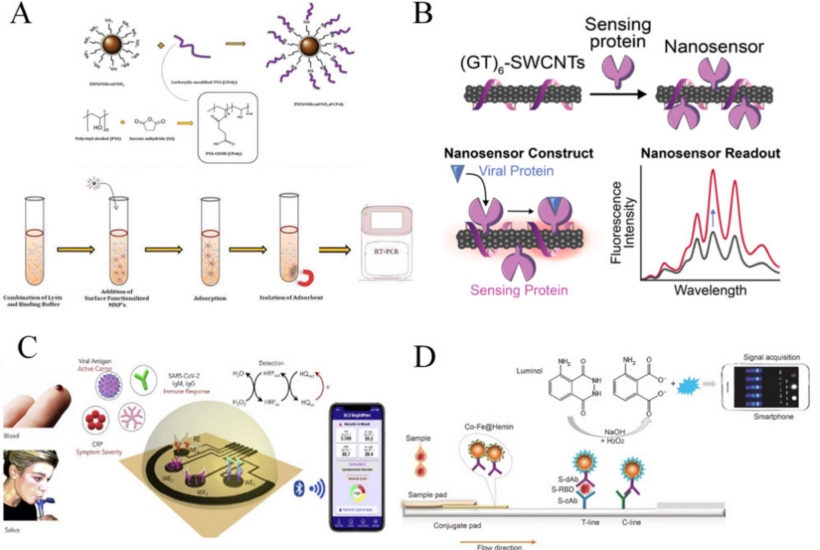
Figure 3. The application of nanoparticles for COVID-19 diagnostics. ( A ) Magnetic particles were used for viral RNA extraction for COVID-19 diagnostics. Adapted with permission from refer- ence [88] Taylor & Francis © (2021). ( B ) The use of a single wall carbon nanotube-based optical sensor for fluorescent detection of COVID-19. Adapted with permission from reference [89] Cre- ative Commons Attribution License © (2021). ( C ) A wireless graphene-based telemedicine platform (SARS-CoV-2 rapidplex) for rapid and multiplex electrochemical detection of SARS-CoV-2 viral proteins, antibodies (IgG and IgM) and inflammatory biomarker c-reactive protein (CRP) in blood and saliva samples. Adapted with permission from reference [90] Elsevier © (2020). ( D ) Development of nanozyme-based chemiluminescent paper-based biosensor for SARS-CoV-2 antigen. Adapted with permission from reference [91] Elsevier ©